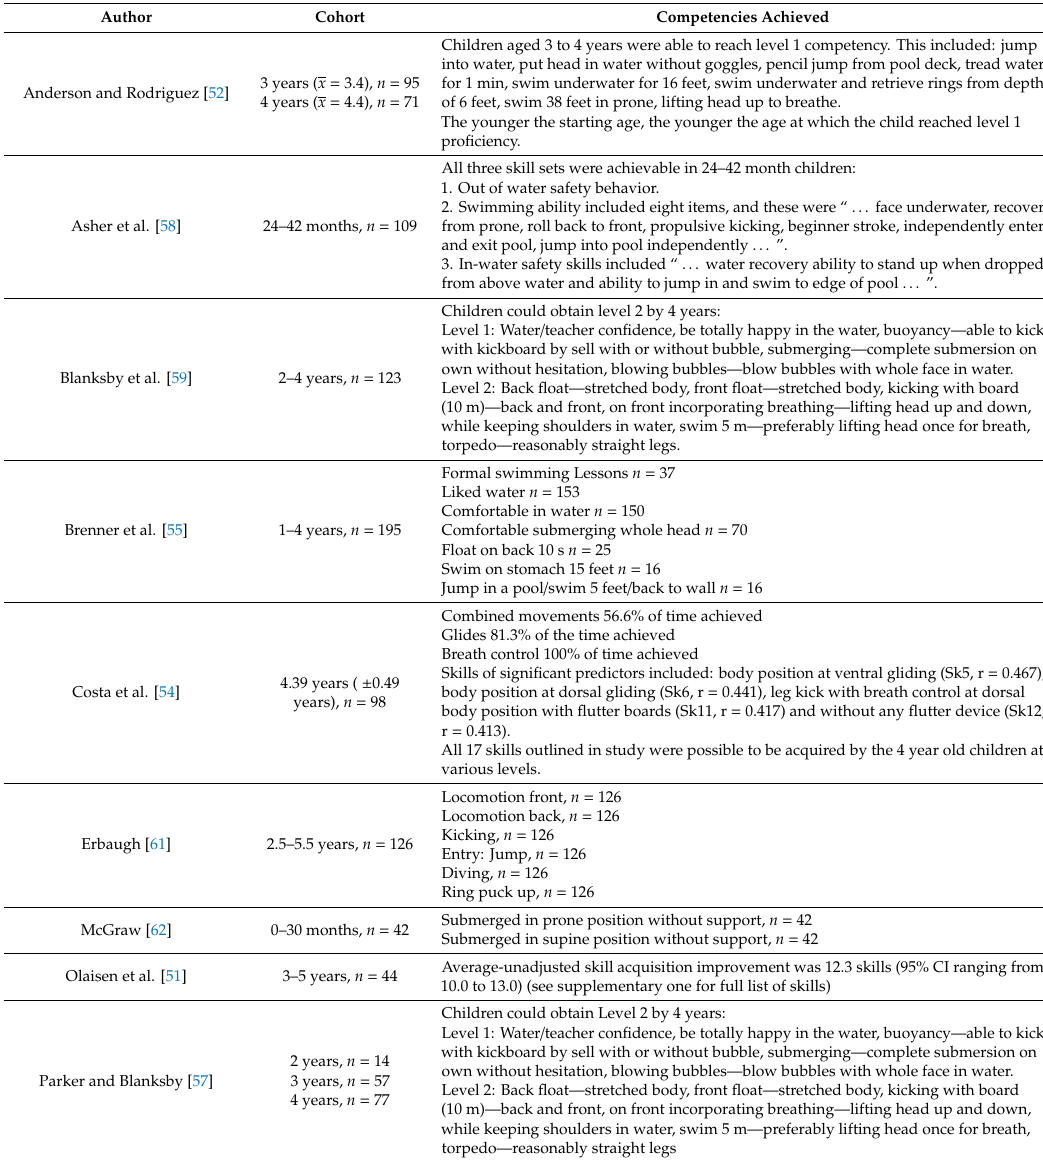
Table 5. Ability to acquire water